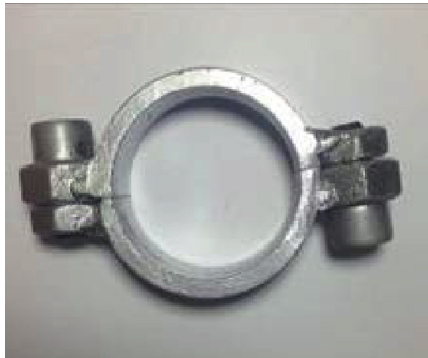
Figure 5: Specimen mold.